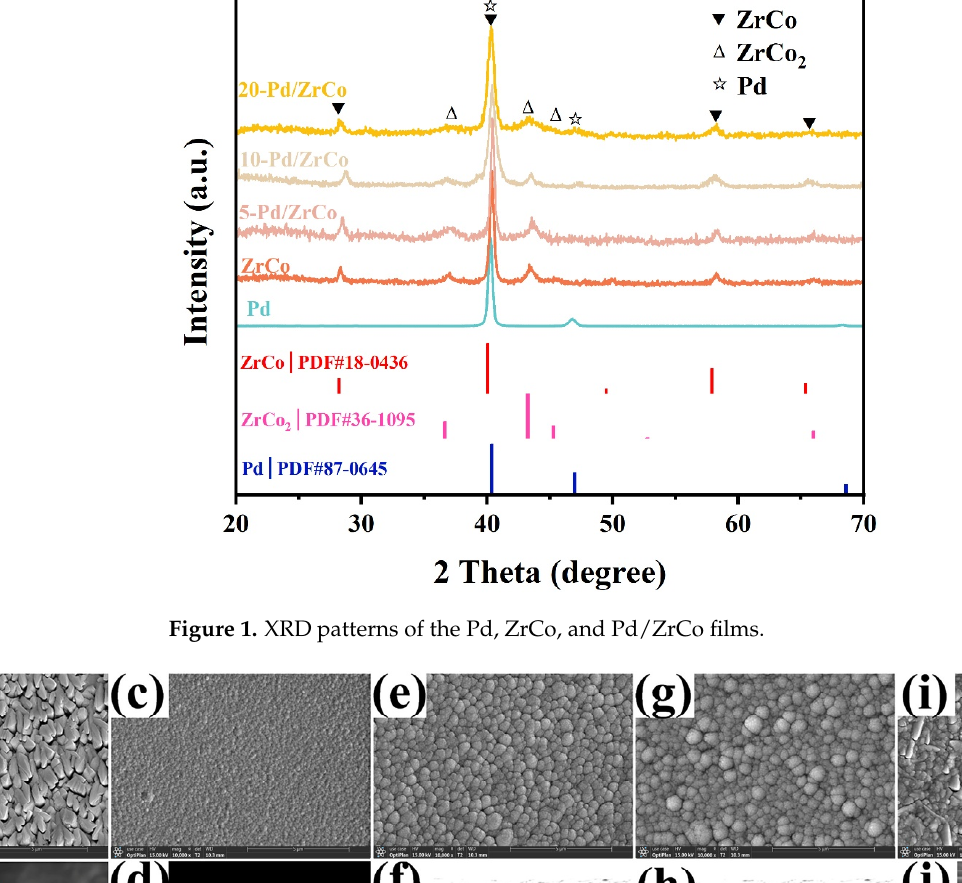
Figure 1. XRD patterns of the Pd, ZrCo, and Pd/ZrCo films.